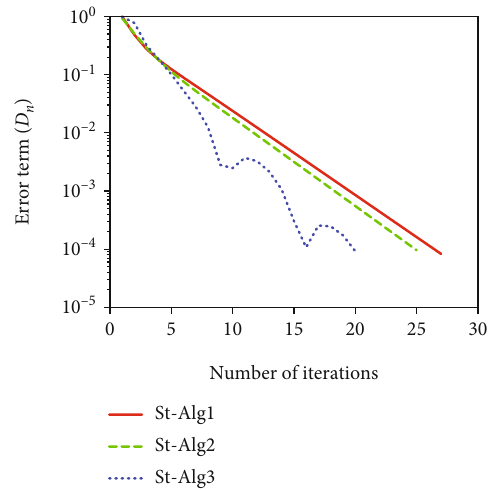
Figure 1: Numerical computational behavior of Algorithm 1:, Algorithm 2:, and Algorithm (4.2) while κ 0 = κ 1 = 2 t + 3